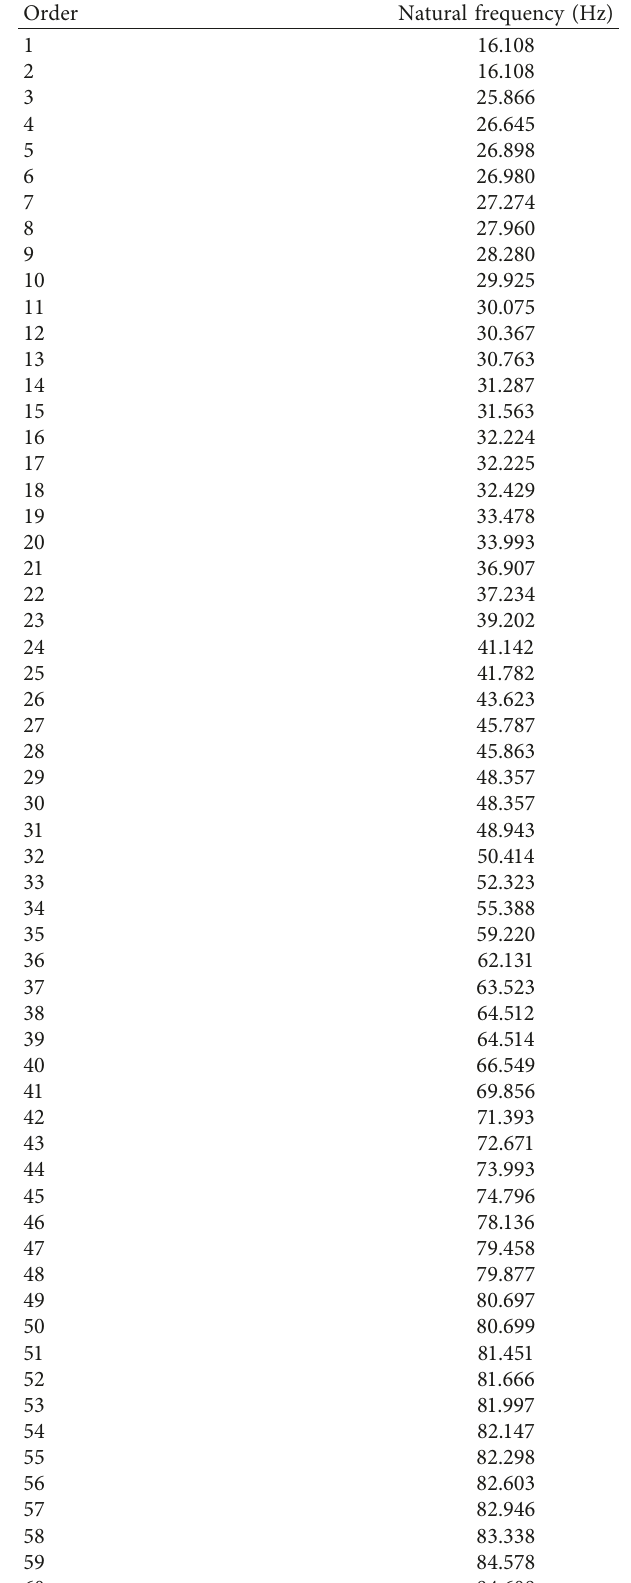
Table 1: Natural frequencies of the track plate